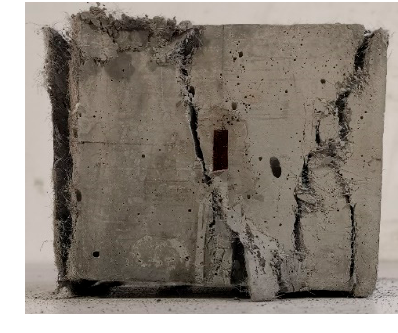
ε & = 10 − 4 ε & . ε = 10 − 4 s − 1 ). = 10 − 4